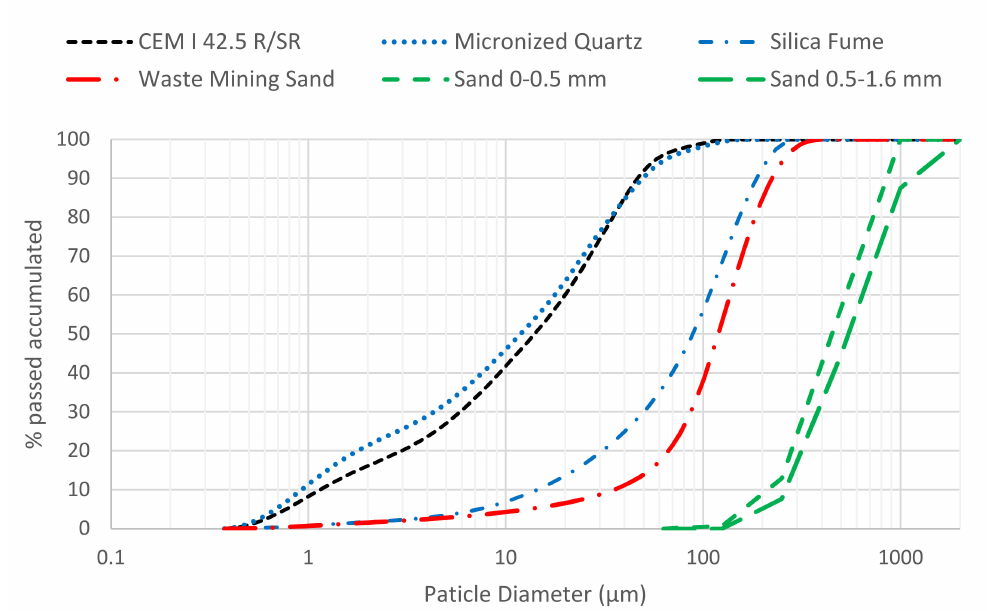
Figure 2. Grading curves of the materials.